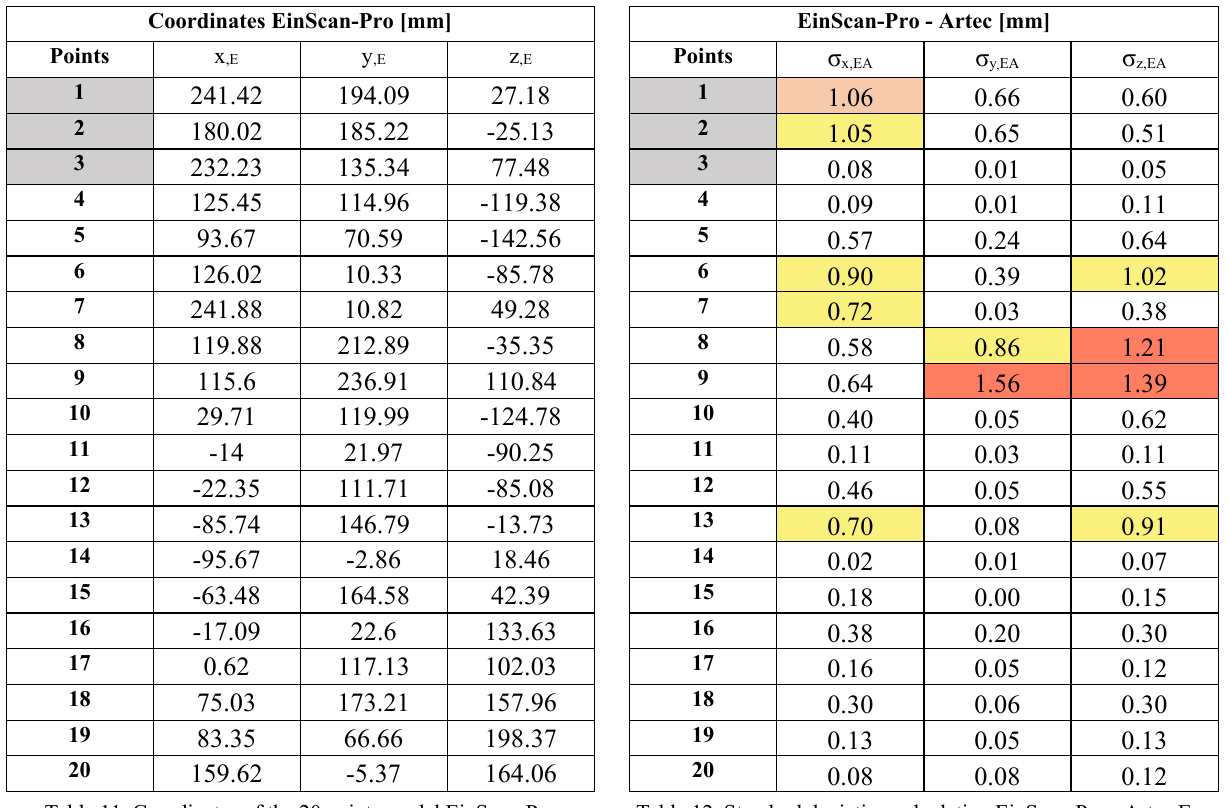
Table 11. Coordinates of the 20 points model EinScan-Pro